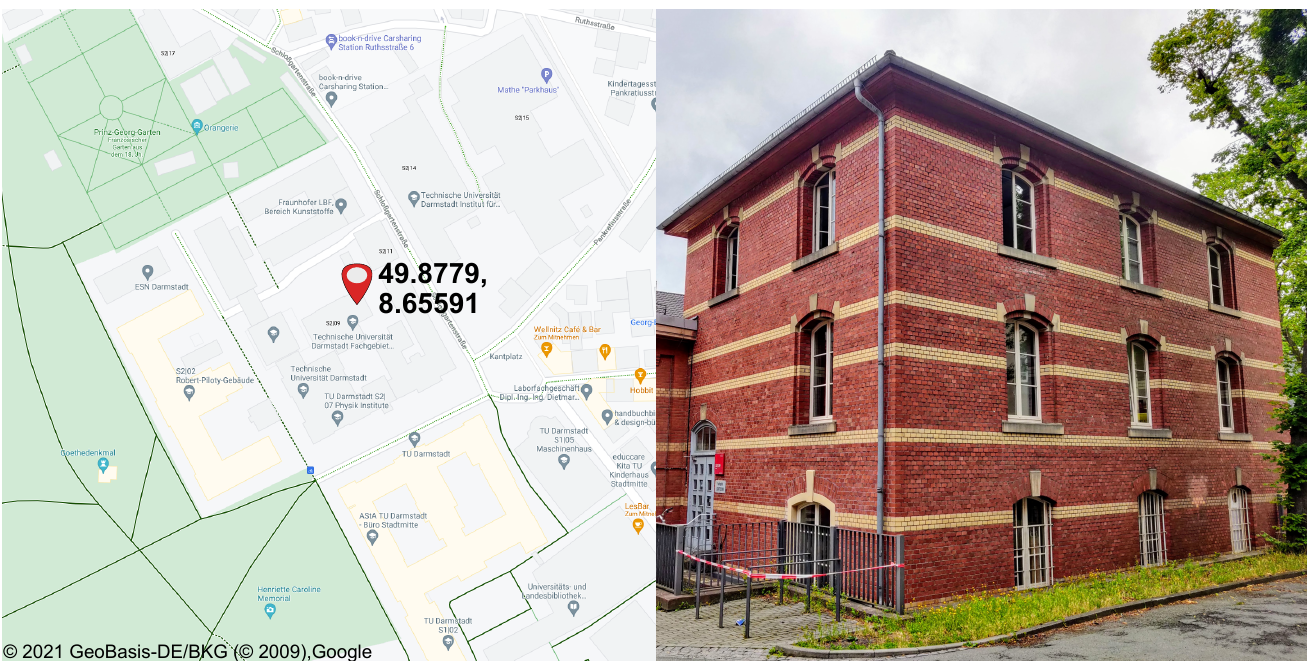
Figure 2. Geolocation ( left ) and image representation ( right ) of the institutional building. The various office workplaces serving as examples to evaluate the proposed methodology for spatially-resolved light measurements are all located on the 2nd floor given by the uppermost row of windows shown on the right.